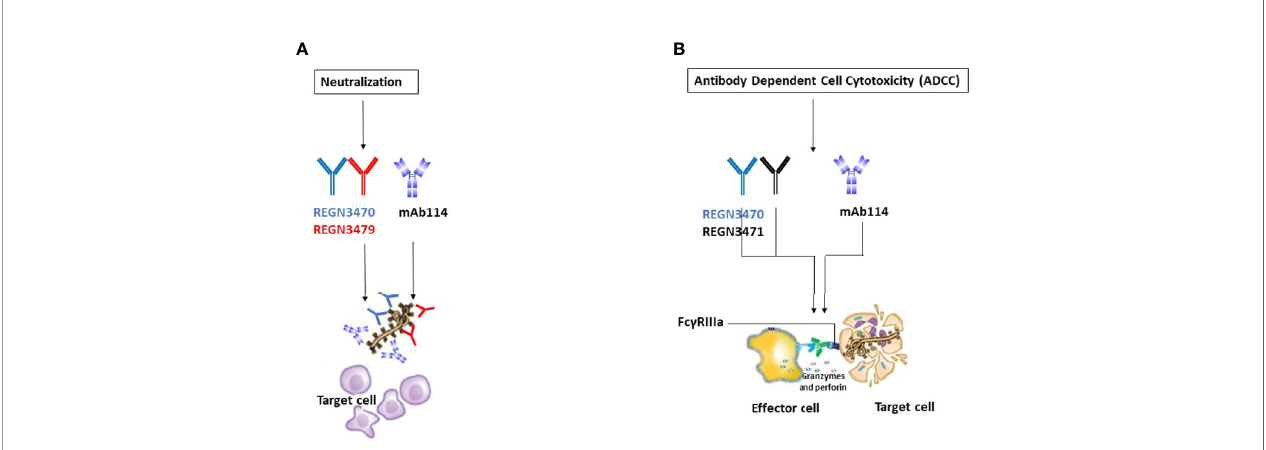
FIGURE 5 | Illustrative mechanisms of FDA-approved mAbs therapeutics. (A) Neutralization Illustrative representation of mAb114 (lavender color) and two REGN- EB3 components [REGN3470 (blue color) and REGN3479 (red color)] neutralization activity. (B) ADCC. Illustrative representation of mAb114 (lavender color) and two REGN-EB3 components [REGN3470 (blue color) and REGN3471 (black color)] ADCC